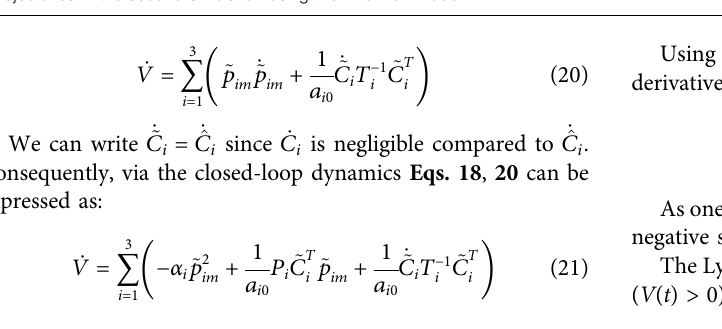
FIGURE 4 | Simulation 2. First row: (A) and (B) are the initial and fi nal shape of the object, respectively. The desired state of the point m is shown as a purple diamond (position) and a dashed line segment (orientation). L is 0.90( m ), M 0 = [0.0000, 0.4500, 1.5708] T , and M fdes = [0.2600, 0.3470, 1.2000] T . After applying the proposed controller, the fi nal state of M is M f = [0.2600, 0.3467, 1.2000] T . Second row: (C) , (D) and (E) are the states of the controlled point regarding to the desired trajectories in the second simulation using the Kirchhoff model.